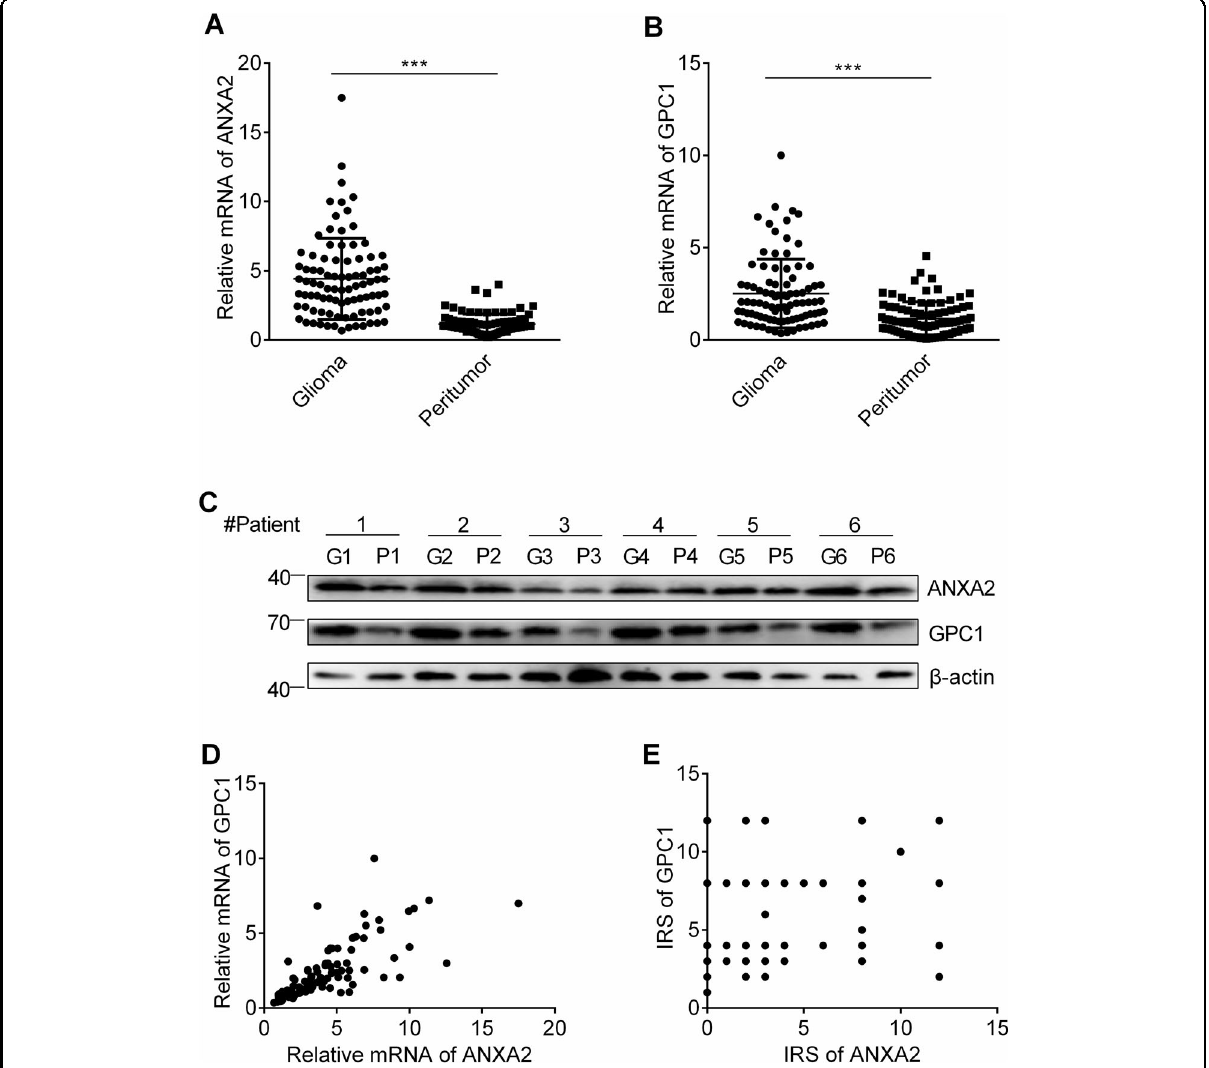
Fig. 3 ANXA2 is upregulated in glioma tissues and coincides with upregulation of GPC1 expression. A , B Relative ANXA2 ( A ) and GPC1 ( B ) mRNA levels among glioma and peritumoral tissues ( n = 90, *** P < 0.001 vs. glioma). C The expression of ANXA2 and GPC1 in the glioma (G) and peritumoral (P) tissues ( n = 6). D Positive correlation between ANXA2 and GPC1 in the glioma samples ( n = 90, r = 0.718, P < 0.001). E Positive correlation between ANXA2 and GPC1 protein levels in the glioma samples ( n = 164, r = 0.23, P <